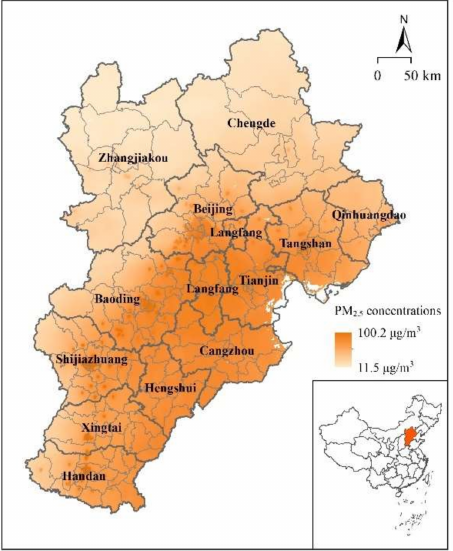
Figure 1. Location of the Beijing–Tianjin–Hebei urban agglomeration and the distribution of atmo- spheric PM 2.5 concentration in